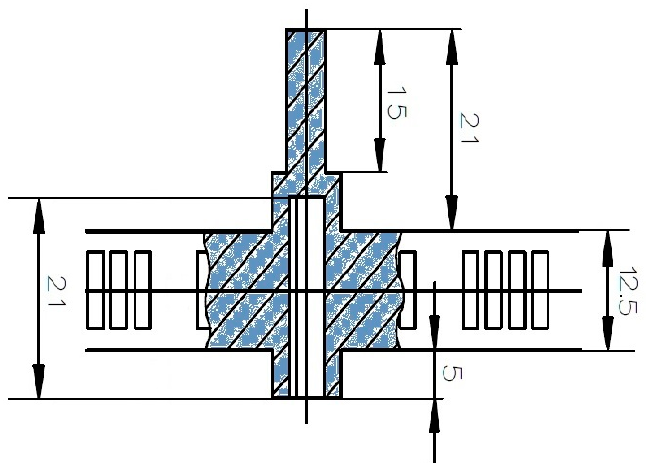
Figure 2. Detail of the central protrusion in a rib and its inner slot required to assemble one part into the other to form a cage (dimensions in mm). Materials 2020 , 13 , x FOR PEER REVIEW